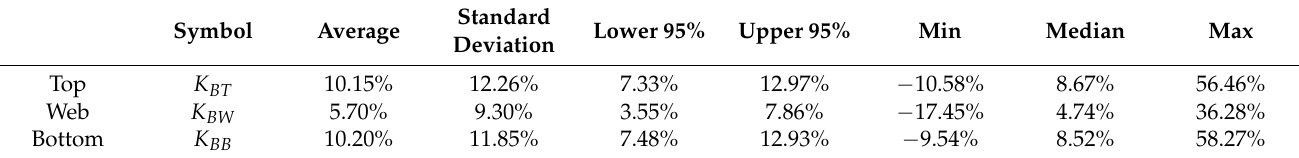
Table 7. Statistically analysis of K i of each part in the cross-section of bridge